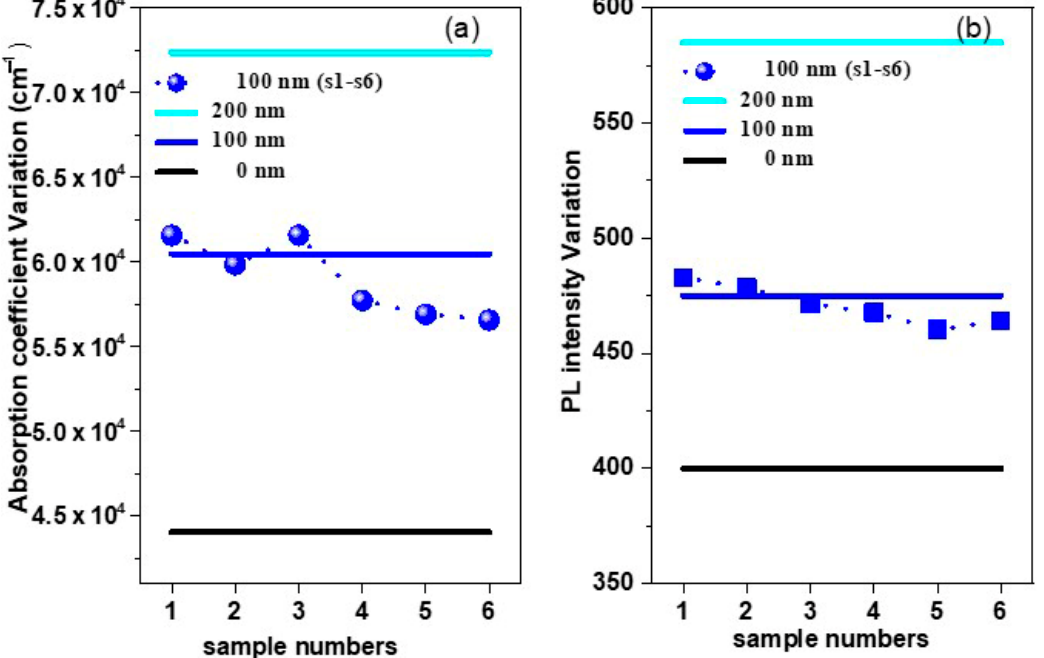
Figure 12. Intensity fluctuation of ( a ) absorption coefficient and ( b ) PL intensity fluctuation of six samples analyzed.